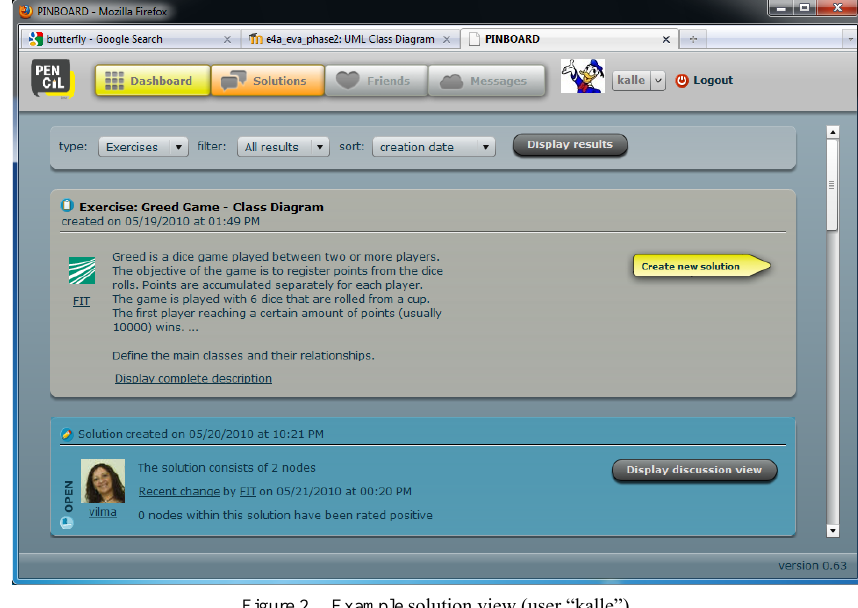
Figure 2. Example solution view (user “kalle”).